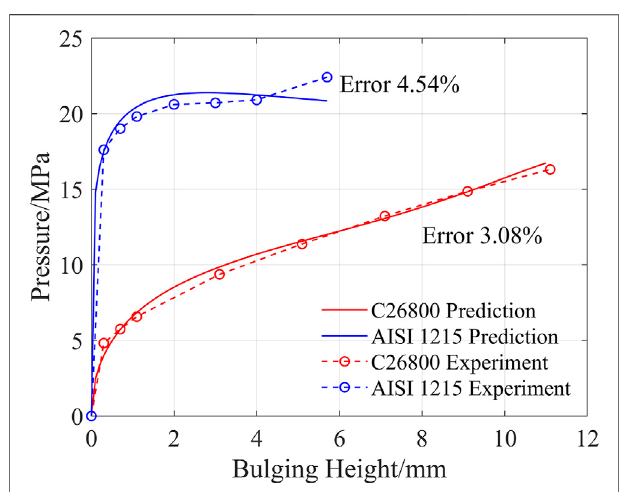
FIGURE 9 | Required pressure evolution during the hydro-bulging process.